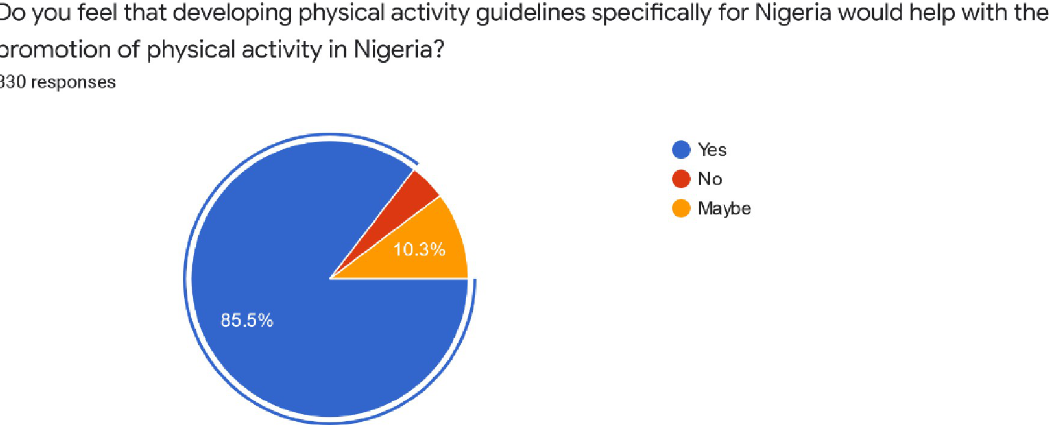
Fig 1. Responses on the need to develop physical activity guidelines specifically for Nigeria.